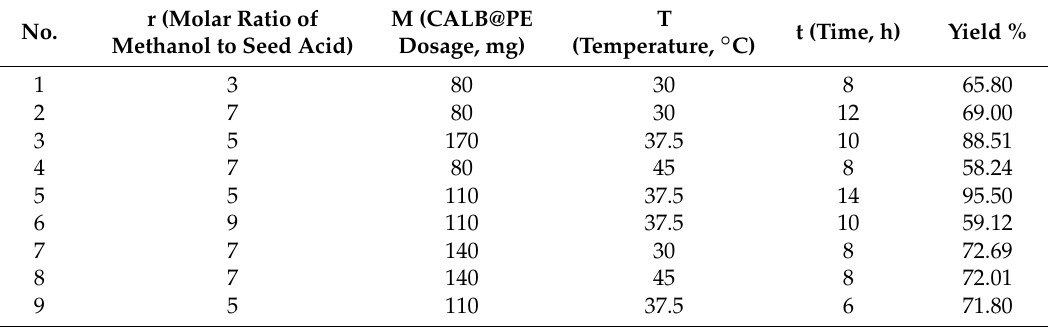
Table 2. Experimental design and results for biodiesel production using a central composite design of response surface methodology